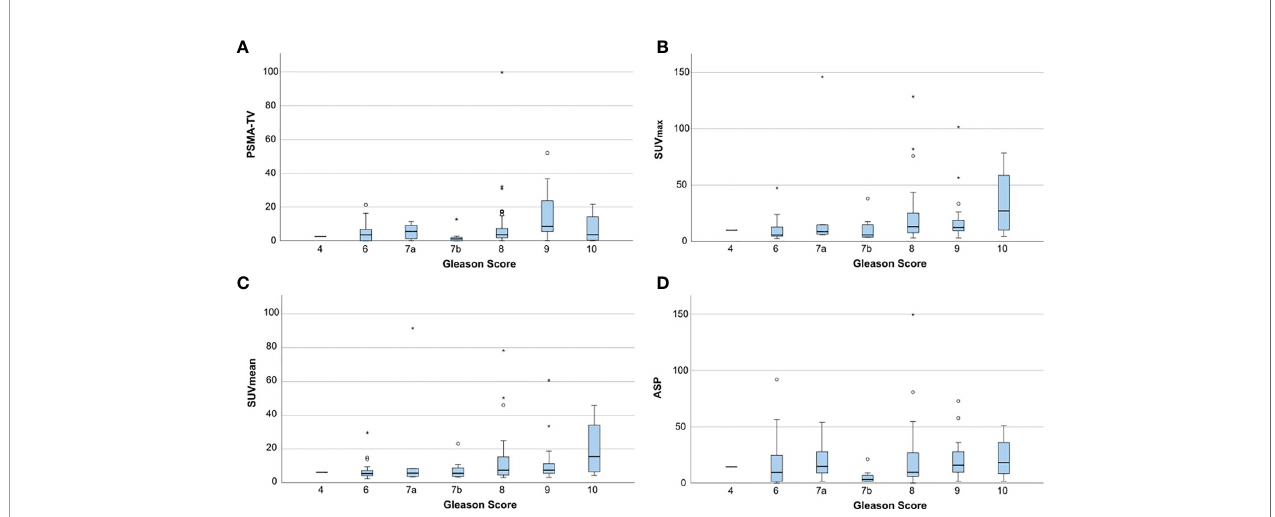
FIGURE 3 | Boxplots showing the distribution of quantitative PET parameters for each Gleason score. (A) PSMA-derived tumor volume (PSMA-TV), (B) Maximum standardized uptake value (SUVmax), (C) Mean standardized uptake value (SUVmean) and (D) Tumor asphericity (ASP). Outliers are plotted as points (< 3 * interquartile range) or asterisks (> 3 * interquartile range).